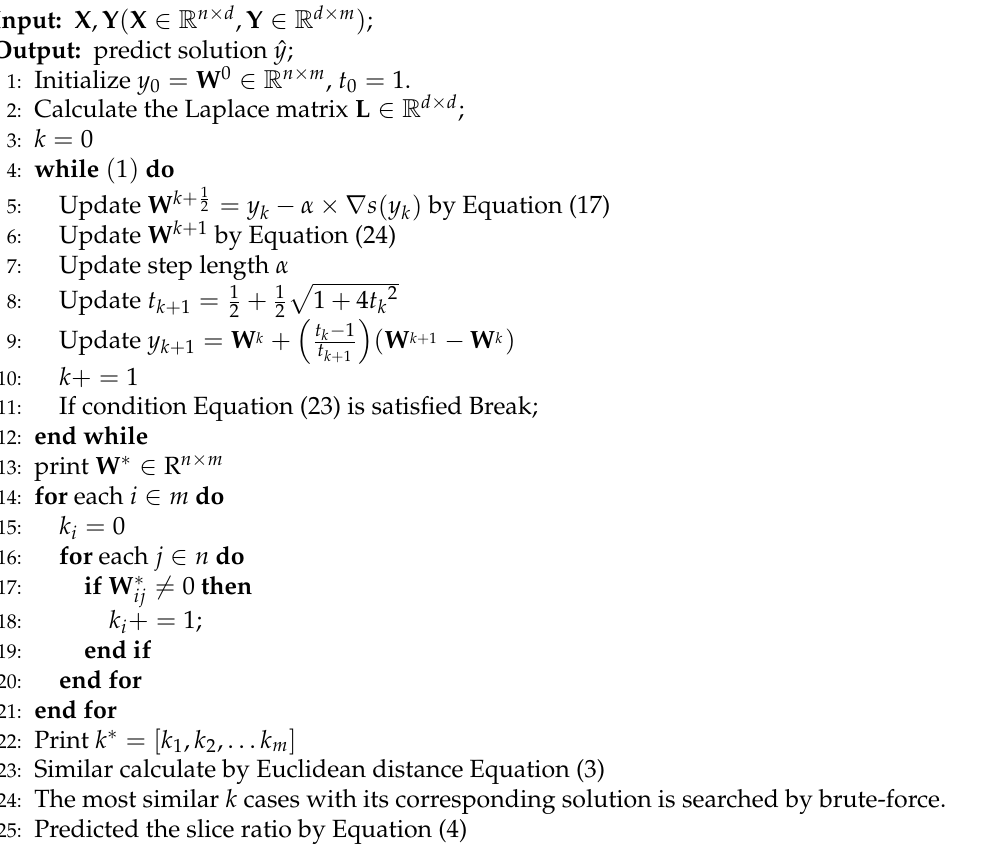
Algorithm 2 Pseudocode of O-KNN.